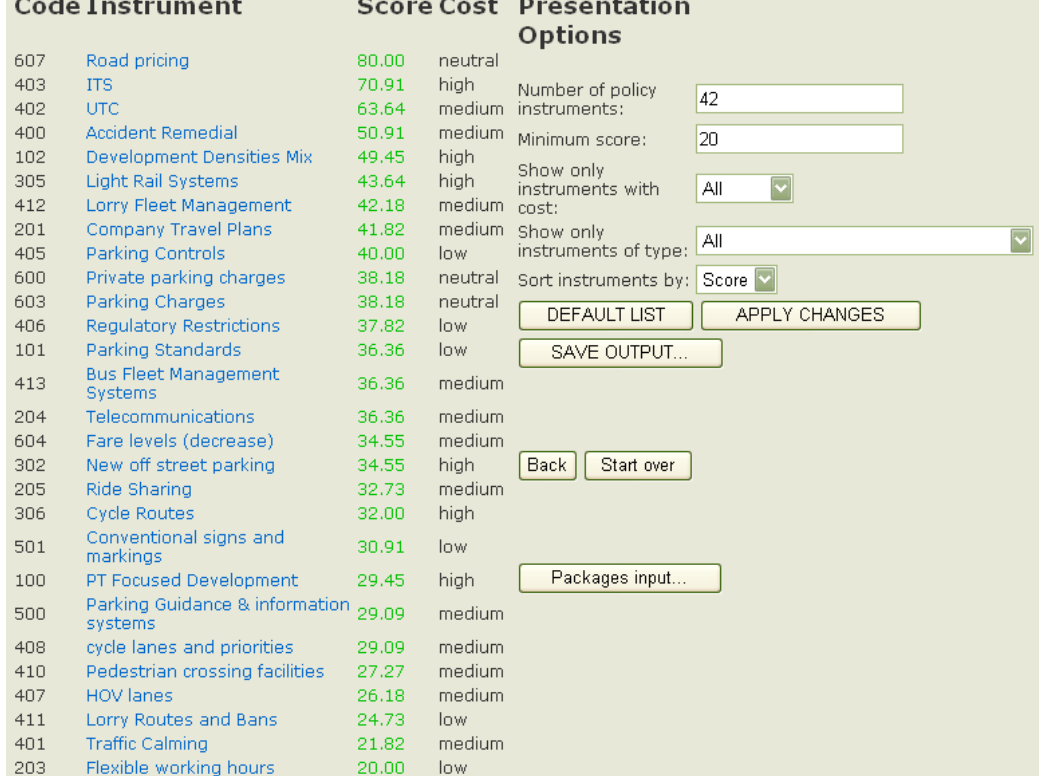
Figure 5. KonSULT Option Generation Output Example (presented for scores> 20) Source: Kelly et al (2008a), Figure